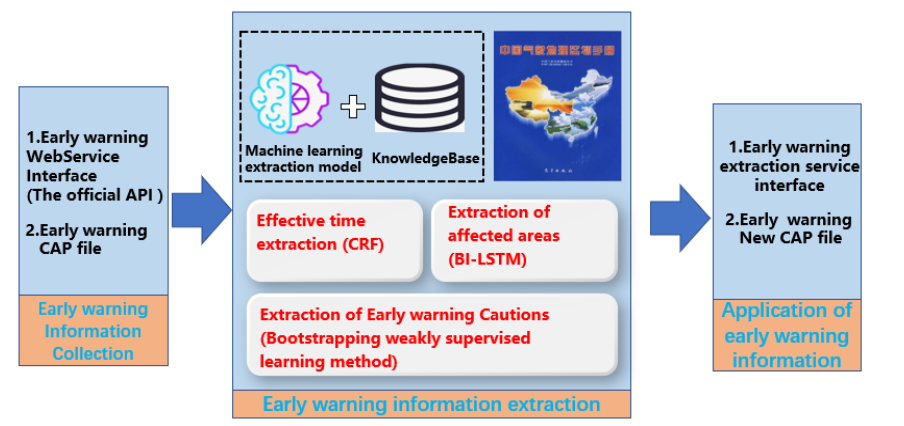
Fig. 1. Extraction process of early warning